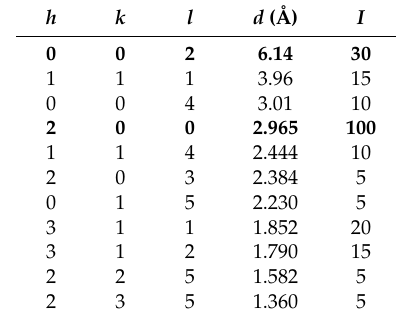
Table 4. X-ray diffraction data (using Cu K α ) belonging to the H -subcell of merelaniite. The three most intense reflections are indicated in boldface type.